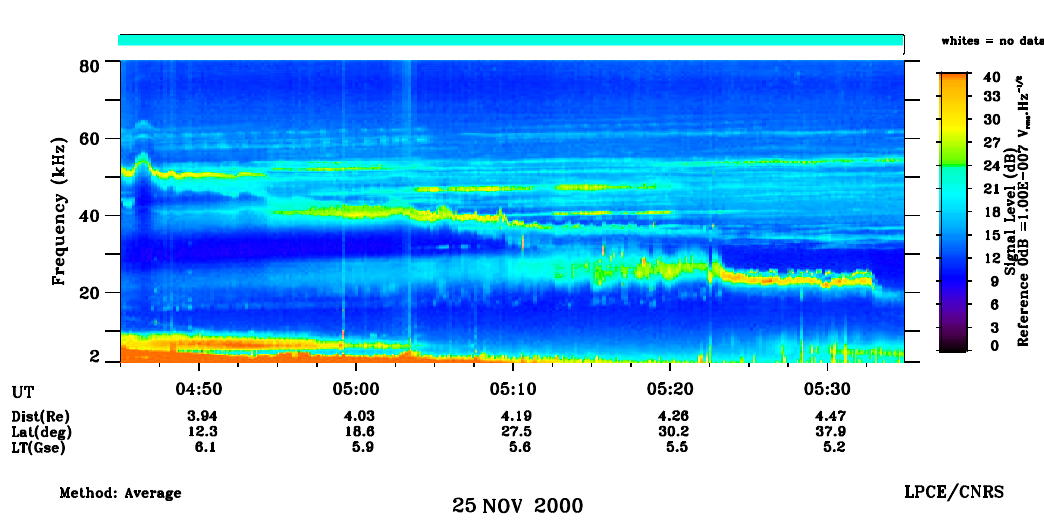
Fig. 3. Dynamic spectrogram obtained from Whisper data on 25 November 2000 from Cluster 1 Rumba. The instrument was in passive mode only. A mixture of narrow band emissions at constant frequencies and stronger waves with decreasing frequencies are observed as the spacecraft recedes from the plasmasphere.